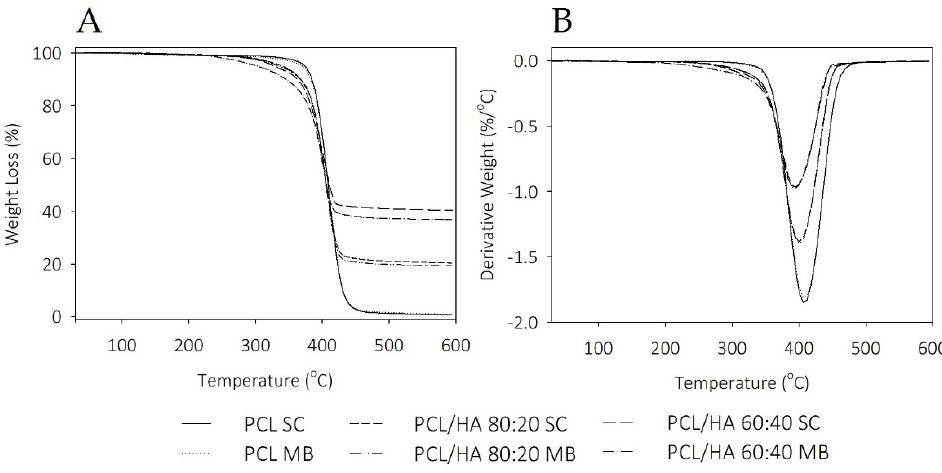
Figure 3. ( A ) TGA and ( B ) DTG results of neat PCL and PCL/HA composites.